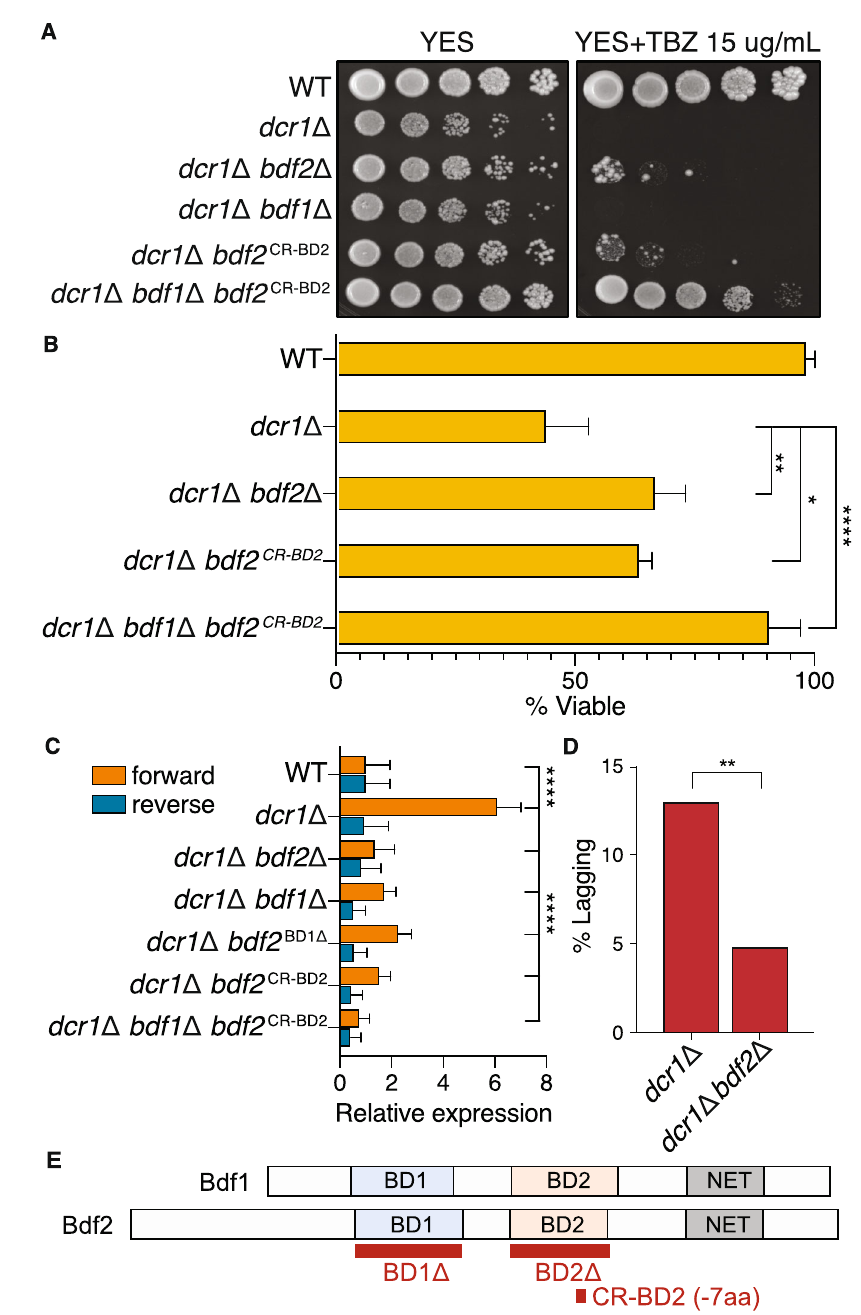
Fig. 5 The genetic interaction of Dicer1 with Brd4 is conserved in S. pombe . A Spot growth assays (10-fold dilutions) on media supplemented with the microtubule poison thiabendazole (TBZ). Mitotic defects of dcr1 Δ are partially suppressed by bdf2 Δ and bdf2 CR-BD2 , restoring viability, and fully suppressed in the triple-mutant dcr1 Δ bdf1 Δ bdf2 CRBD2 , which mimics the 7 amino acid deletion in BD2 found in Dicer1 − / − ES cells (Fig. 2E). B The loss of viability at G 0 - entry seen in dcr1 Δ mutants is also suppressed in dcr1 Δ bdf2 Δ and dcr1 Δ bdf2 CRBD2 , and is fully rescued in the triple-mutant dcr1 Δ bdf1 Δ bdf2 CRBD2 . Barplots represent the mean, error bars represent SD. **** − p -value < 0.0001, ** − p -value between 0.001 and 0.01, * − p -value between 0.01 and 0.05, two-sided t-test. ( N = 4 independent biological experiments). Source Data are provided in the Source Data fi le. C Forward strand dh pericentromeric transcripts accumulate to high levels in dcr1 Δ mutants relative to the reverse strand, but are strongly reduced in double mutants with bdf1 Δ and bdf2 Δ , reversing strand preference. Silencing was fully restored in dcr1 Δ bdf1 Δ bdf2 CRBD2 . **** − p -value < 0.0001 – two-sided t -test. ( N = 3 independent biological replicates). D Knockout of Bdf2 in bdf2 Δ reduces the lagging chromosome phenotype of dcr1 Δ mutants. ** − p -value between 0.001 and 0.01 – Fisher ’ s exact test, two- tailed, N = 100 cells. E Schematic representation of BD1 and BD2 deletions used.